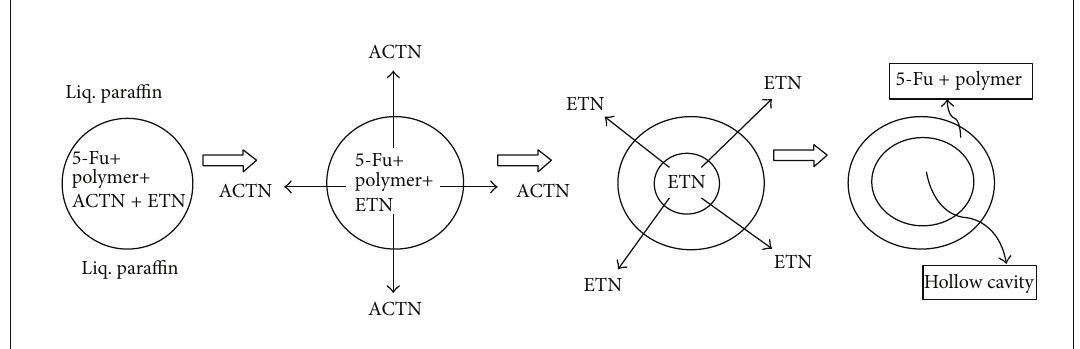
Figure 8: Mechanism of formation of floating hollow